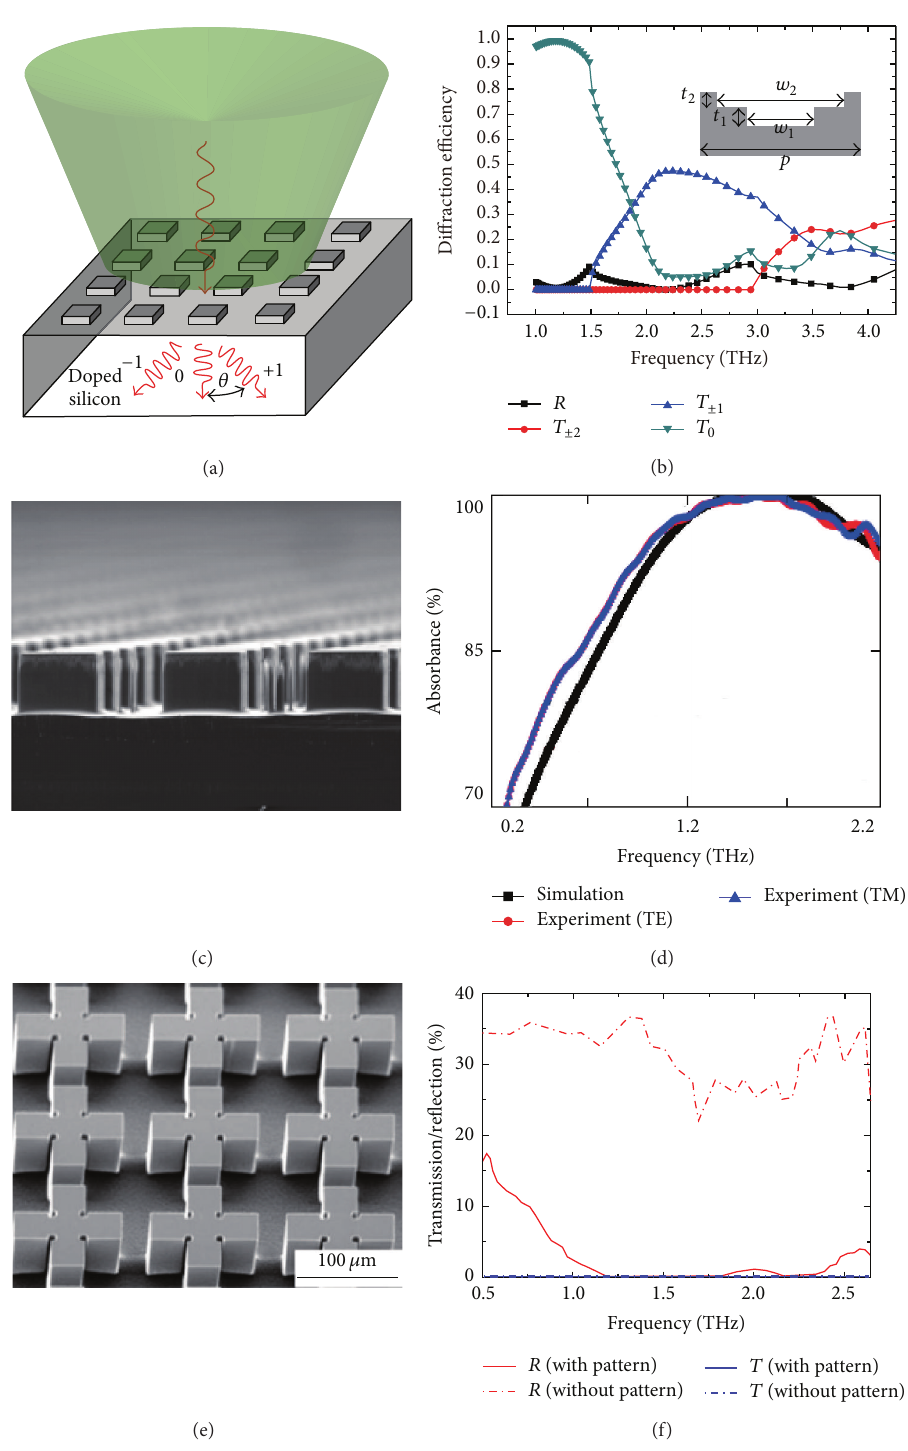
Figure 17: (a) Schematic of the metasurface absorber made out of silicon grating. (b) Calculated diffraction efficiency of a grating. (c) Fabricated sample. (d) Measured absorption coefficients. (e) Fabricated sample of a complex silicon grating. (f) Measured transmission and reflection coefficients with and without pattern. Figures are reproduced from (a, b) [117], (c, d) [118], and (e, f)